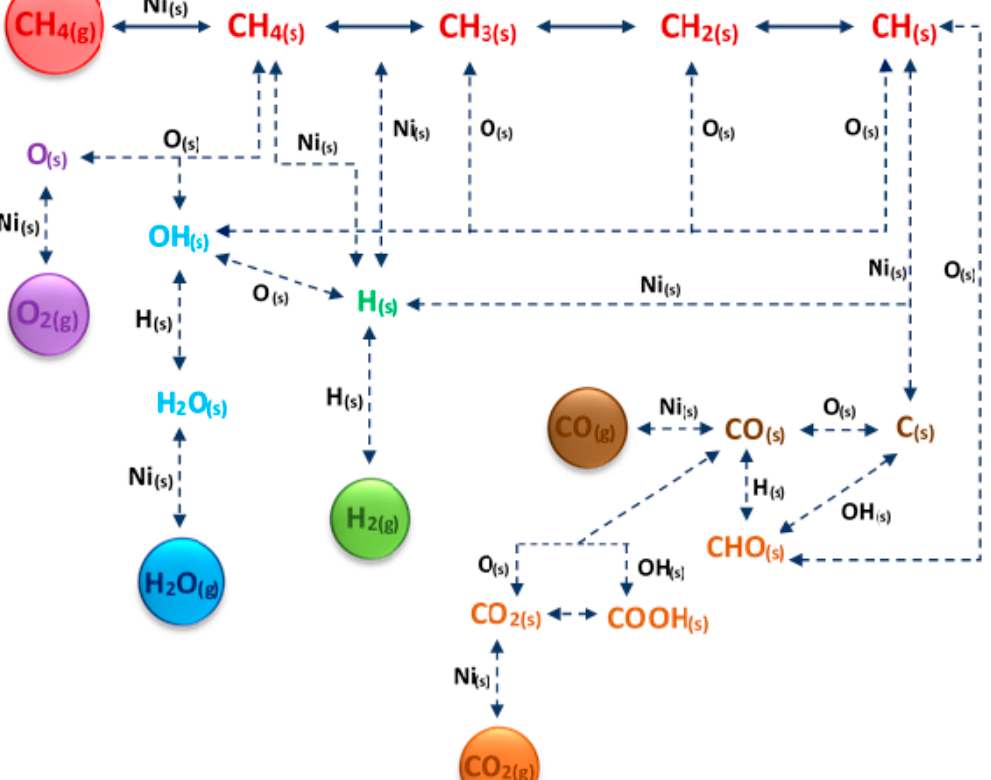
Figure 6. The methane oxidation and reforming reactions pathways performed on nickel based catalyst [110].